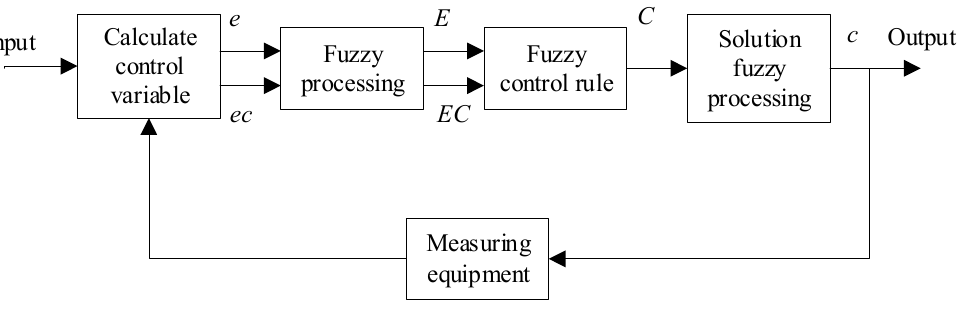
Figure 7. Fuzzy control principle.